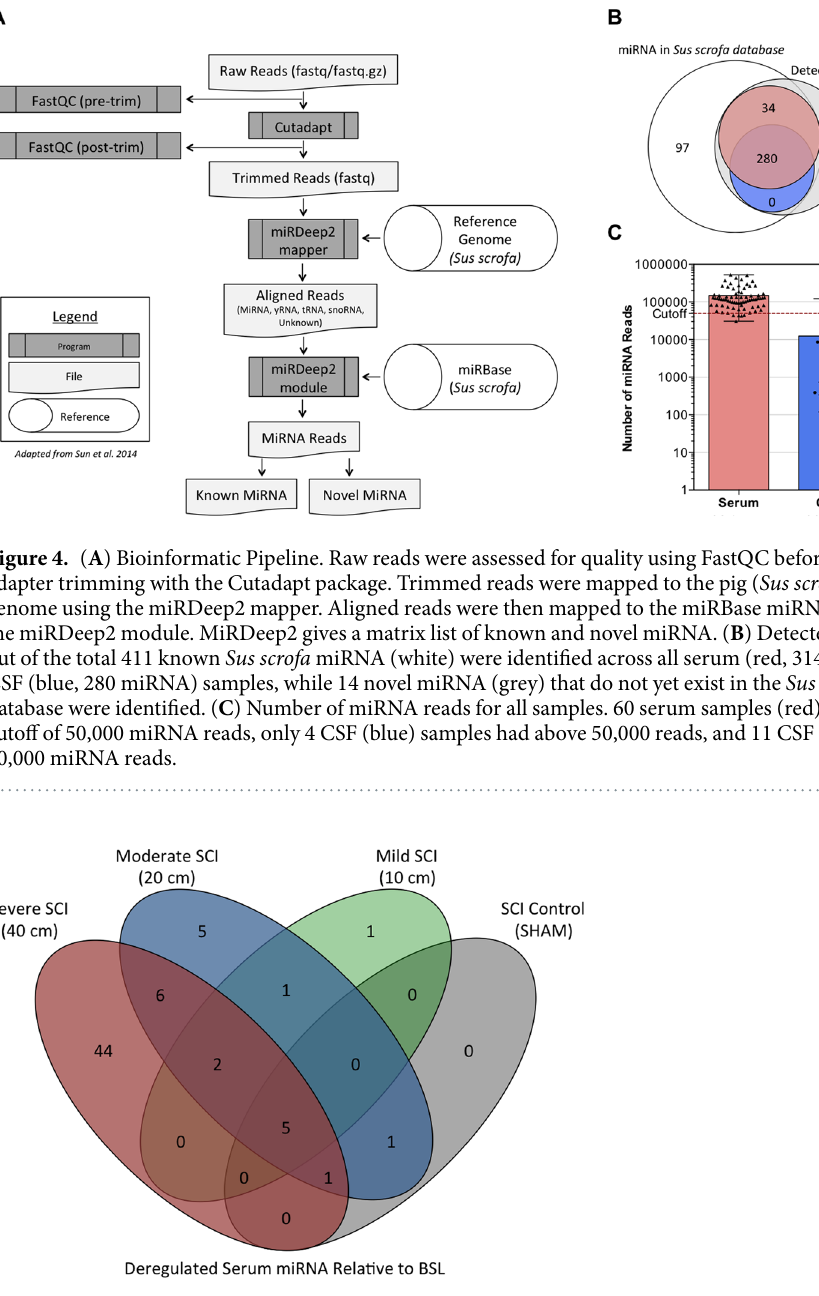
Figure 5. Venn diagram showing numbers of deregulated serum miRNA after severe (40 cm, red), moderate (20 cm, blue), mild (10 cm, green) injury, or SHAM surgery (Non-CNS Injury control, black). Deregulated miRNA were determined by multiple t-tests, while adjusting the p-value using the Benjamini-Hochberg